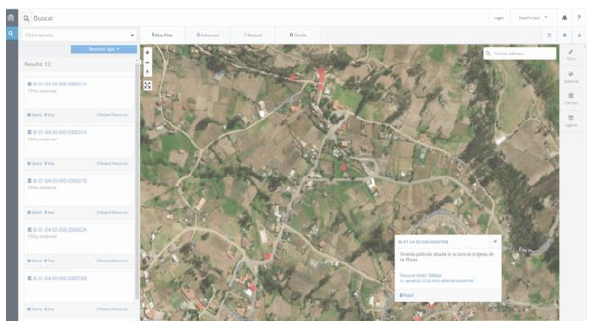
Figure 12 . Nabón’s heritage geoportal